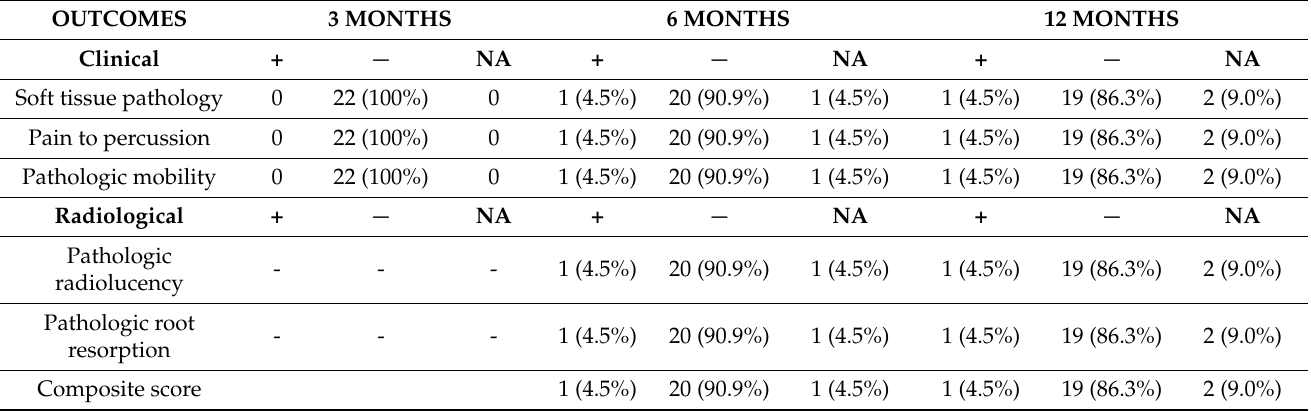
Table 1. Clinical and radiological outcomes and composite score outcomes at 3, 6 and 12